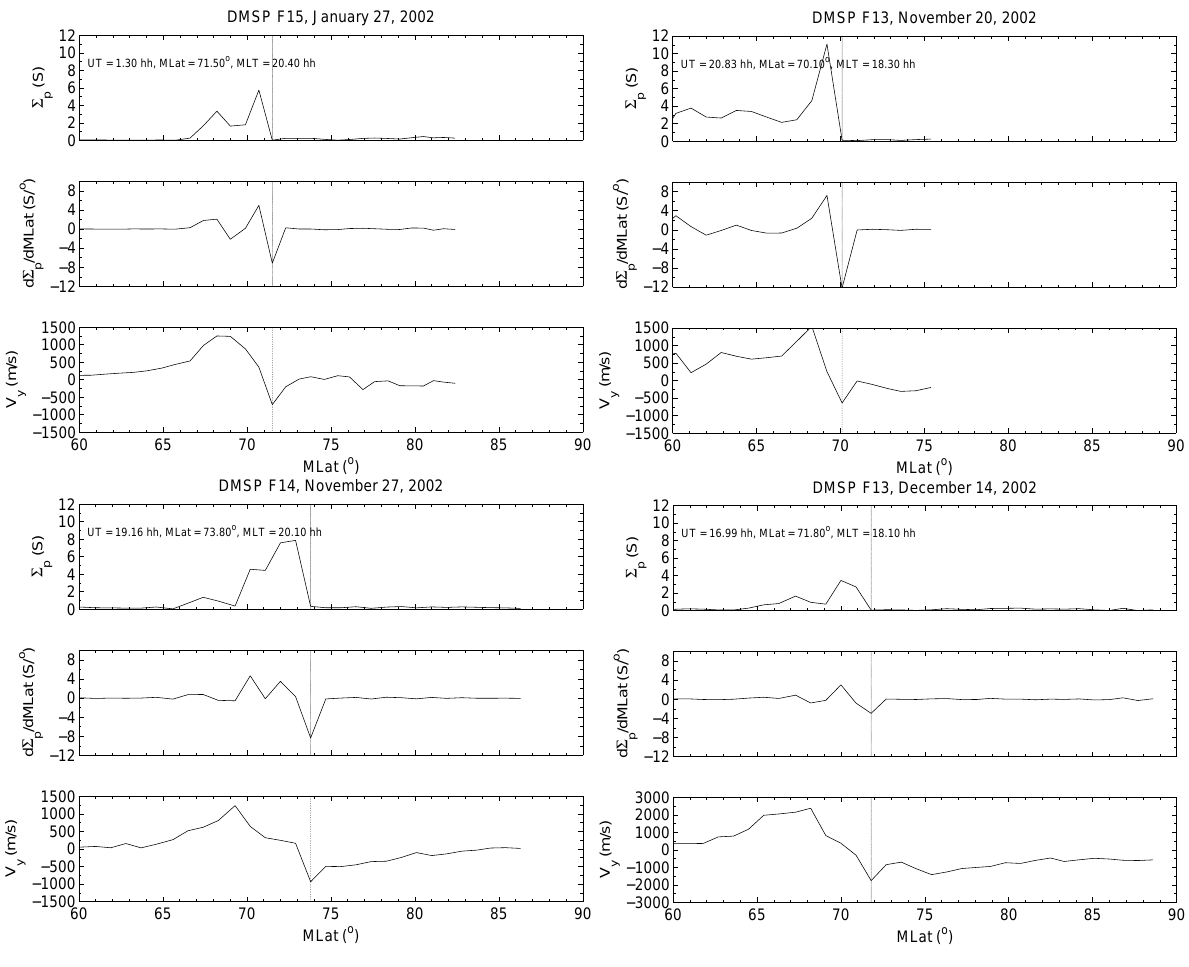
Fig. 2. Examples of the observed latitude profile of Pedersen conductivity ( 6 P ), its latitudinal gradient ( d6 p /d MLat), and the ionospheric convection velocity ( V y ) as obtained from DMSP F13 on 20 November 2002 and 14 December 2002, F14 on 27 November 2002, and F15 on 27 January 2002. The enhanced anti-sunward (negative) plasma drift near the auroral boundary is the plasma jet, which is coincident with the jump of the Pedersen Conductivity. The peak velocity of the jet is indicated by the dashed line. The UT, MLat, and MLT where the velocity peak occurs are also